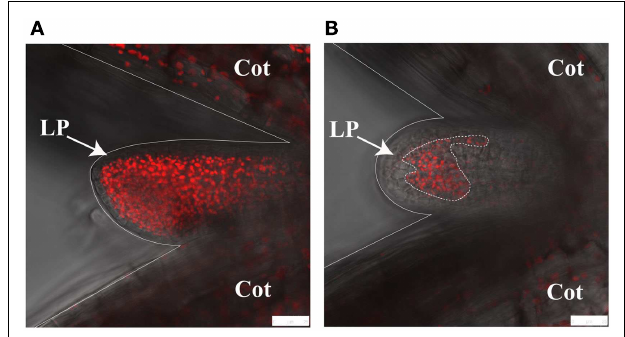
FIGURE 3 | Confocal microscopy of leaf primordia. The images show first leaf primordia (LP) and flanking cotyledons (Cot) from wild type (A) and immutans (B) . Images were captured by taking a confocal image of autofluorescence (red) and overlaying it with a non-confocal transmitted light image (gray). Plants were grown at 22˚C under continuous illumination for 3days at 5 µ mol photons m − 2 s − 1 followed by 2days at a light intensity 100 µ mol photons m − 2 s − 1 .White scale bars represent 25 µ